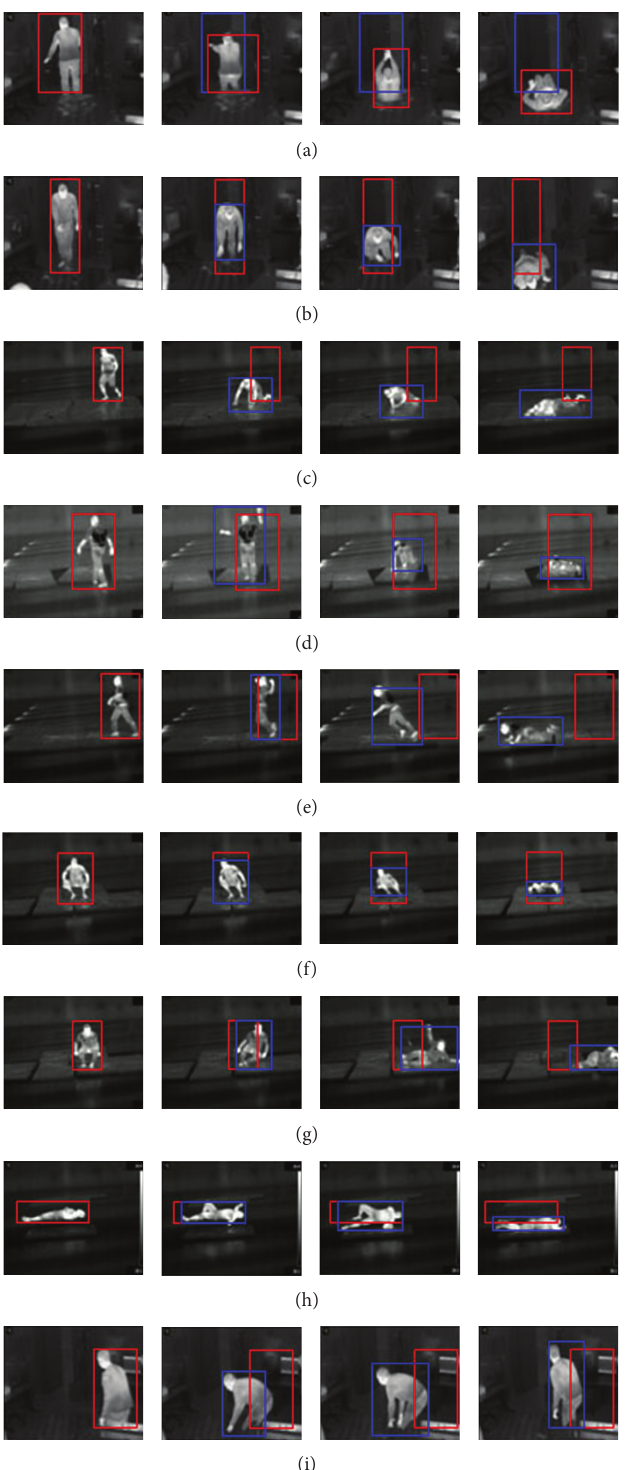
Figure 3: True and false falls recorded with an infrared camera. Static falls from a “standing” position: (a) falling backward, (b) falling forward and (c) falling to the left. Dynamic falls from a “standing” position: (d) falling forward and (e) falling to the left. Falls from a “sitting” position: (f) falling backward and (g) falling to the right. (h) Falling from the “lying” position. (i) False fall: